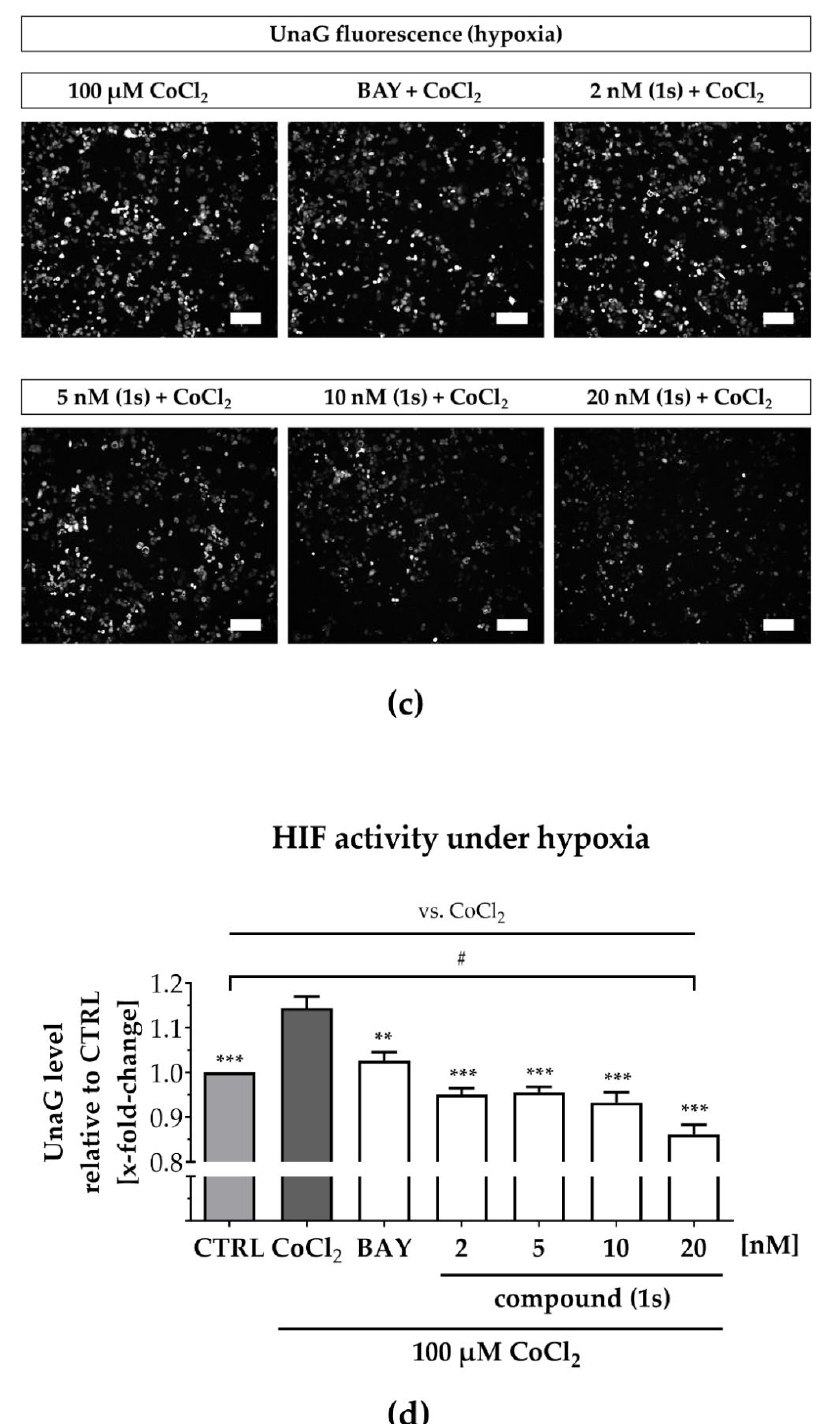
Figure 7. Compound ( 1s ) decreases HIF-dependent gene transcription. MDA-MB-468-UnaG cells were pre-treated for 1 h without (CTRL) or with compound ( 1s ) or BAY 11-7085 (BAY) before being grown ( a , b ) in the absence (normoxia; CTRL) or ( c , d ) presence of 100 µM CoCl 2 (hypoxia) for another 24 h. ( a , c ) Representative fluorescence images. Scale bar: 200 µm ( b , d ) Total fluorescence intensity of HIF-mediated UnaG was normalized to the CTRL group. Statistical difference was calculated with one-way ANOVA ( b ) vs. CTRL (normoxia) (ns = not significant, * p < 0.05). ( d ) vs. CTRL (hypoxia) (# p < 0.05); vs. CoCl 2 (* p < 0.05, ** p < 0.01, *** p < 0.001). ( b , d ) Columns represent the mean ± SEM ( n =